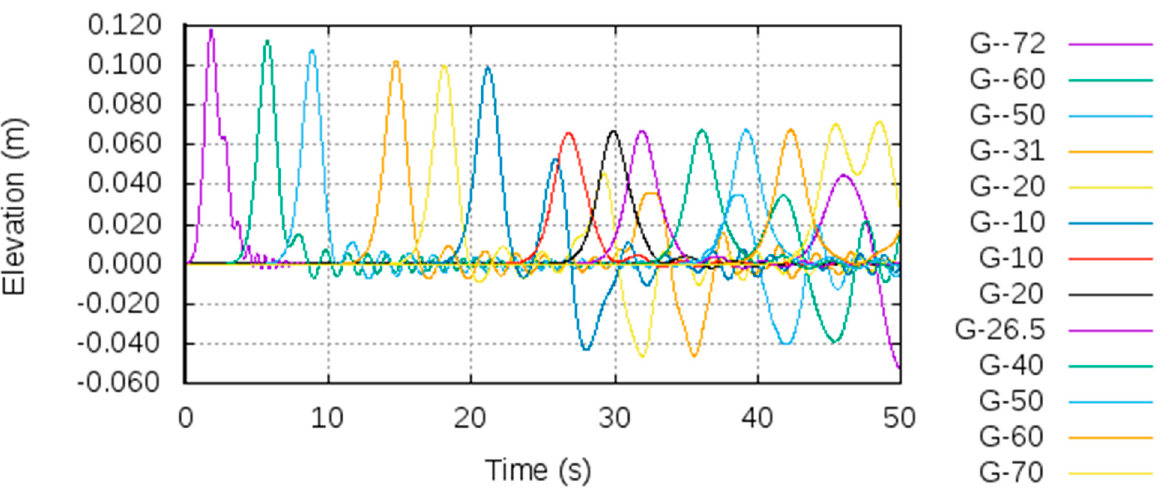
Figure 7. Free surface elevations measured by different wave gauges along the simulation domain (see [27], 0.1 a h =